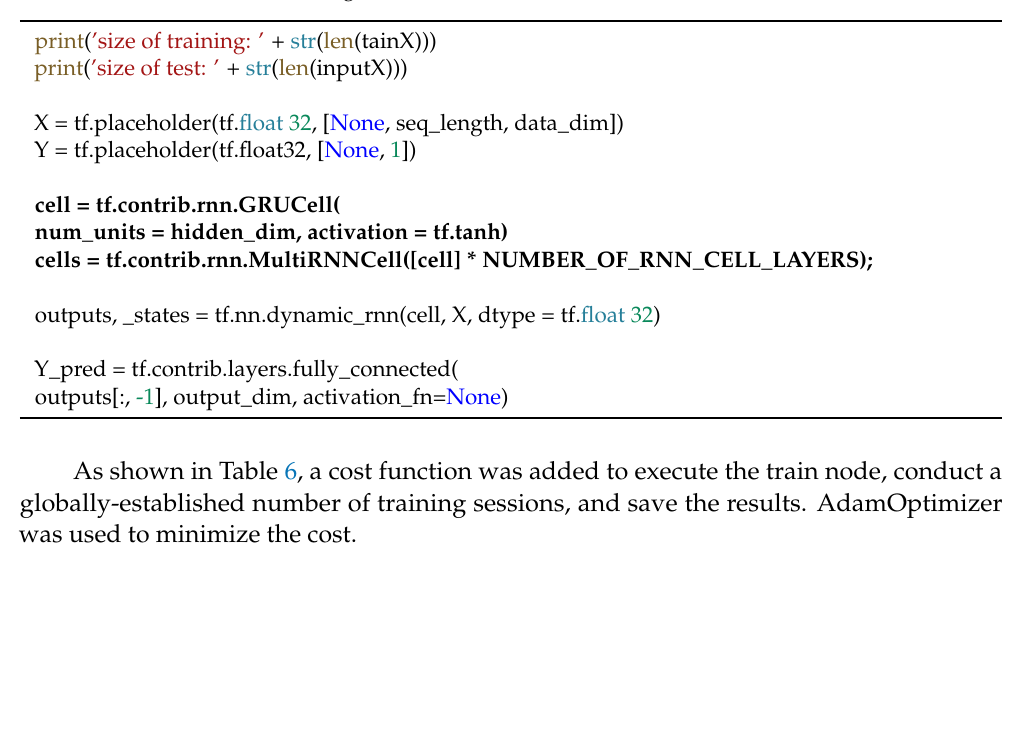
Table 5. Main code of the training